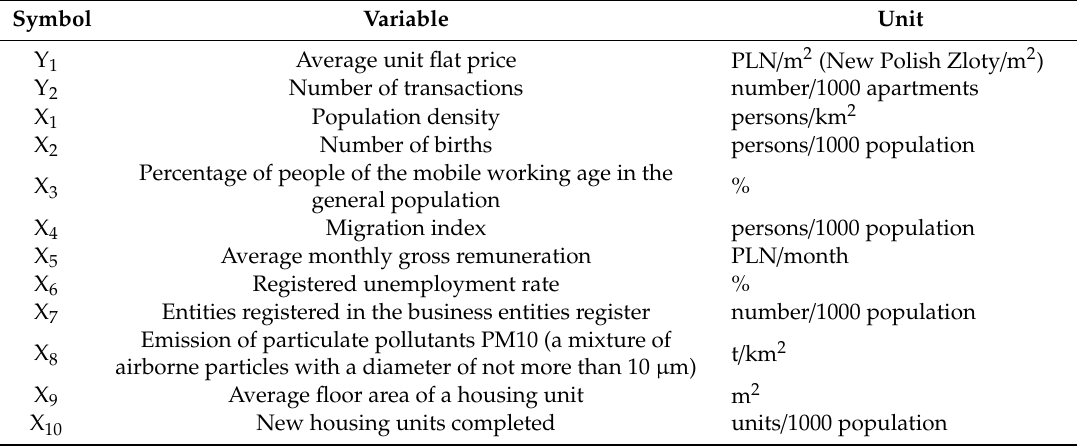
Table 1. Variables taken for